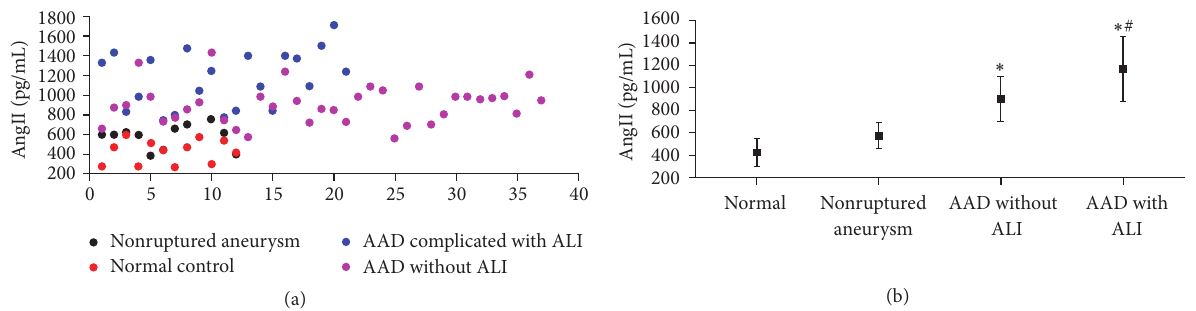
Figure 1: Circulating AngII is elevated in the blood samples from AAD complicated with lung injury patients. (a) AngII was assayed by the systems for each marker in the human peripheral blood samples from healthy control volunteers ( 𝑛 = 12 ); patients with nonruptured, chronic aortic aneurysm ( 𝑛 = 12 ); AAD patients without ALI ( 𝑛 = 37 ); or AAD complicated with ALI patients ( 𝑛 = 21 ). (b) The concentration of serum AngII in AAD complicated with lung injury patients was higher than the other groups. ∗ 𝑃 < 0.05 versus control, # 𝑃 < 0.05 versus